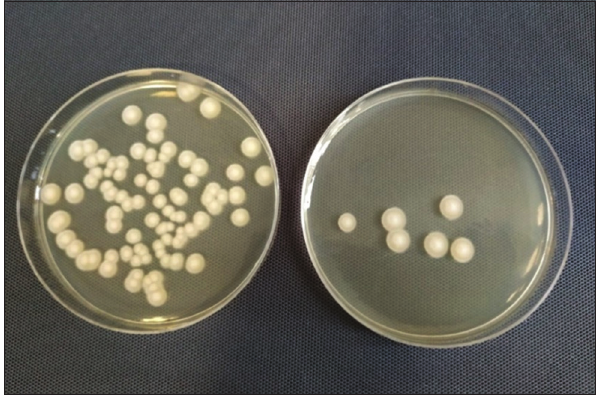
Means marked with different letters differ significantly: capital letters - for p≤0.01; lowercase letters - for p≤0.05